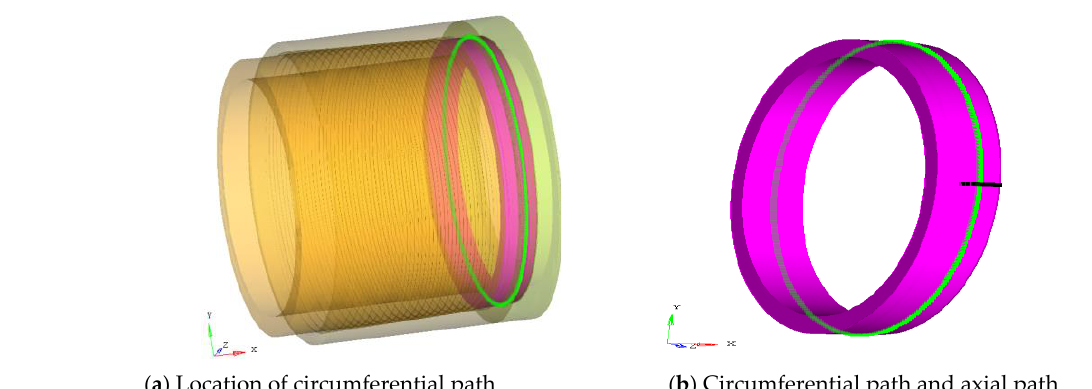
Figure 8. Sealing structure of the casing connection. A higher contact stress and a larger contact width are the two important features of an excellent sealing performance in the elastic range. The stress on the sealing surface has greatly exceeded the elastic limit. Meanwhile, there is plastic deformation which is helpful to the sealing performance in a certain range. Therefore, it is difficult to accurately describe the micro channel on the sealing surface, which increases the difficulty of evaluating the sealing performance of the sealing surface. In view of both elastic and plastic deformation, fluid leakage will appear in the direction of small leakage resistance, so the fluid leakage resistance is also affected by the contact stress and contact width of the sealing surface. The contact pressure along the axial path on the wear side of the sealing surface was se- lected (as shown in Figure 7) to analyze the variation of stress characteristics with different wear depths. The simulation results of the model showed that the width of the sealing surface of the connection corresponding to different wear depths are the same (3.75 mm); thus, only the contact stress on the sealing surface is discussed below. The node with the maximum contact stress on the sealing surface was taken from the axial path (the intersection of the green-color circumferential path and the black-color ax- ial path is shown in Figure 7b); for simplicity, it is referred to as node A2. Node A2 is the node of maximum stress on the axial path and the critical node for sealing the connection;